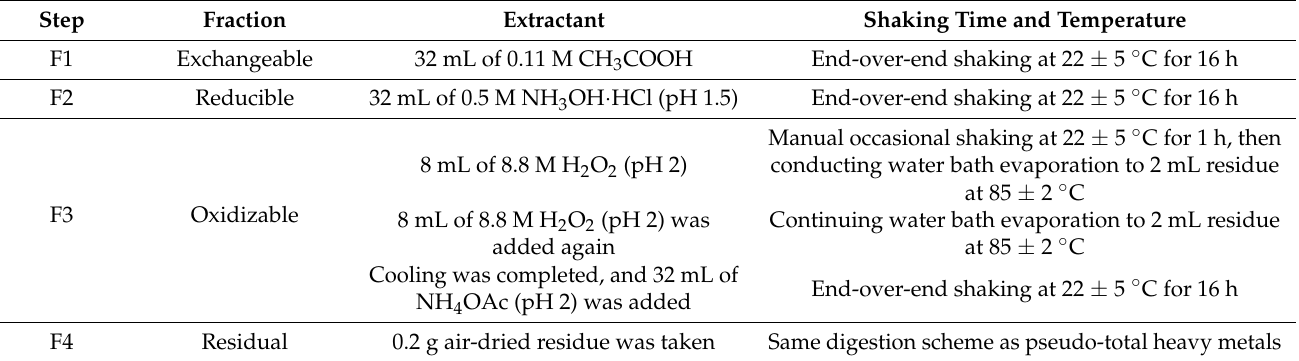
Table 1. Modified BCR sequential extraction scheme used for heavy metal